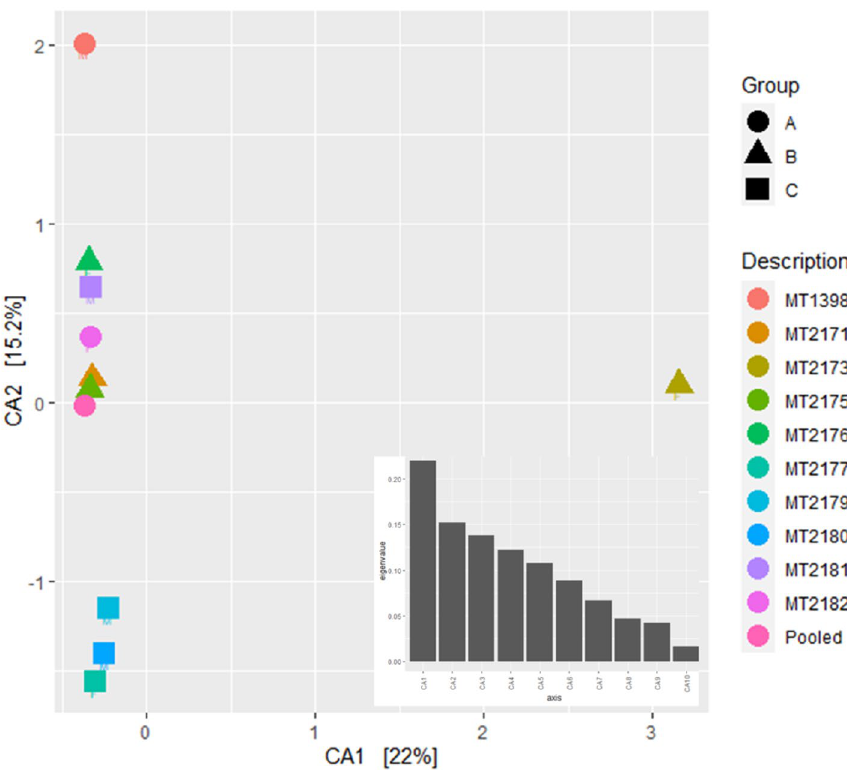
Figure 5. Cannonical correlation plot showing three out of four samples in group C clustered together and the dysbiotic sample (MT2173) showed highest variation from other